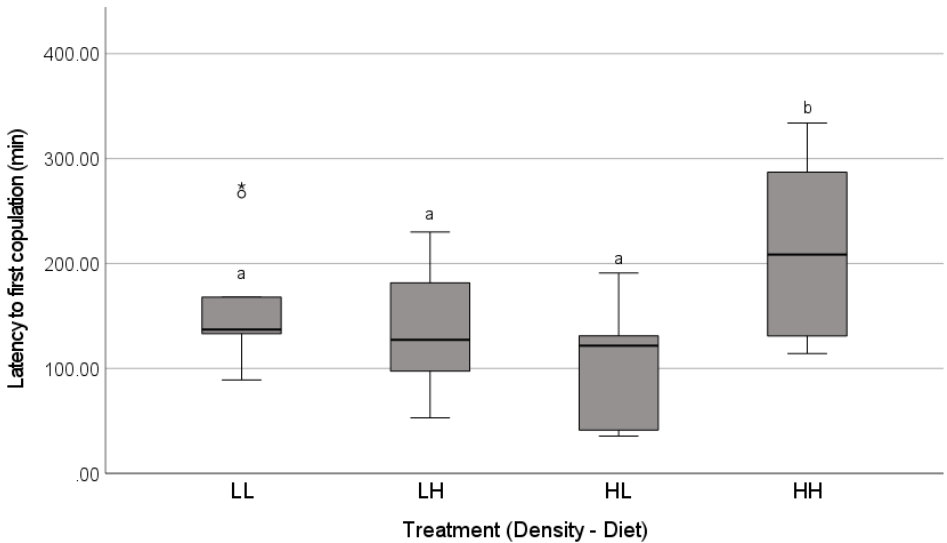
Figure 3. Total latency (min) prior to the first successful copulation for the females reared for their last two instars in treatments that crossed two levels of exposure to airborne chemical cues of low (L) or high (H) male density with two diet levels (low, L or high, H). The adult females were then paired with a novel male in a laboratory mating trial. Family line effects were con- trolled by using four females from each of 10 family lines, where one female was placed in each treatment. The boxplots show the medians (solid line), the range between the first and third quartiles (inter-quartile range, IQR, box), the maximum and minimum values excluding outliers (whiskers), a potential outlier (open circle, 1.5 – 3x IQR above the third quartile), and an extreme value (>3 x IQR above the third quartile). Different letters above box plots (a,b) indicate significant differences among treatments (S = sequential Bonferroni pairwise post-hoc tests, p < 0.05).